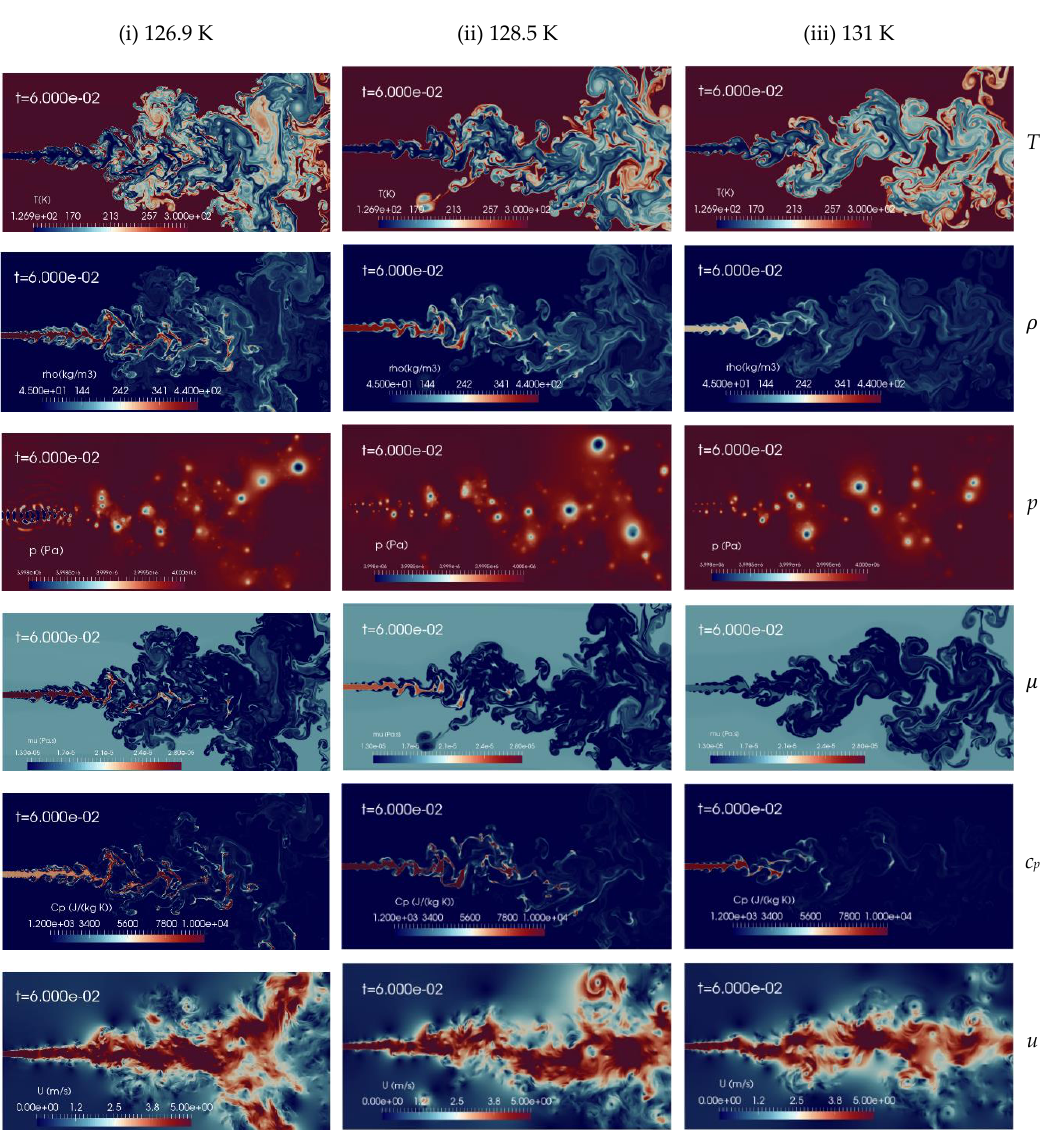
Figure 5. Instantaneous contour plots obtained from simulations of cryogenic L-N 2 injected at 4.9 m/s into G-N 2 at supercritical chamber conditions, 4 MPa and 298 K, for various injection temperatures: first column 126.9 K, second column 128.5 K, third column 131 K. Rows, from top to bottom, show instantaneous fields of temperature T [K], density 𝜌 [kg/m 3 ], pressure p [Pa], dynamic viscosity 𝜇 [𝑃𝑎 ∙ 𝑠 ], specific heat at constant pressure c p [J/(kg K)], and velocity u [m/s].